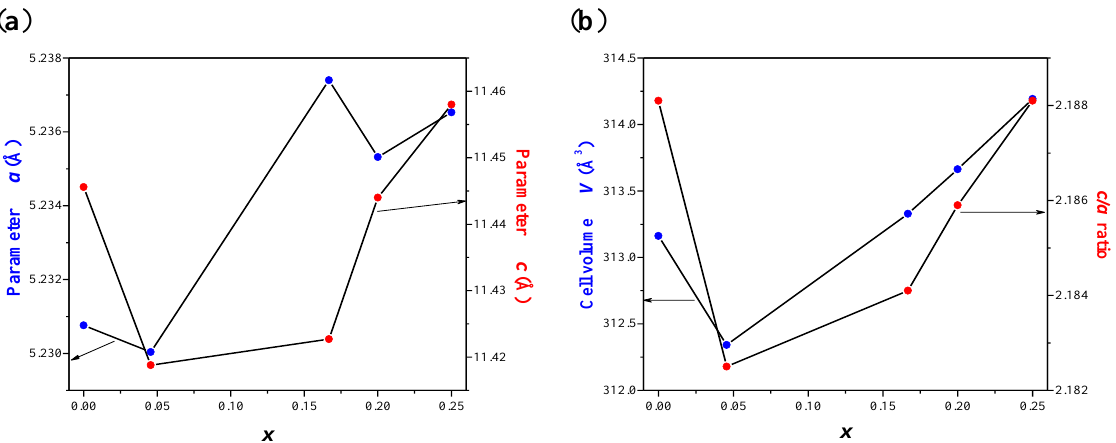
Figure 3. Variation of a and c unit cell parameters ( a ) as well as volume of unit cell ( V ) and lattice parameter ratio c / a ( b ) of CaMnGdMoWO samples obtained by high-temperature sintering as a function of x value.